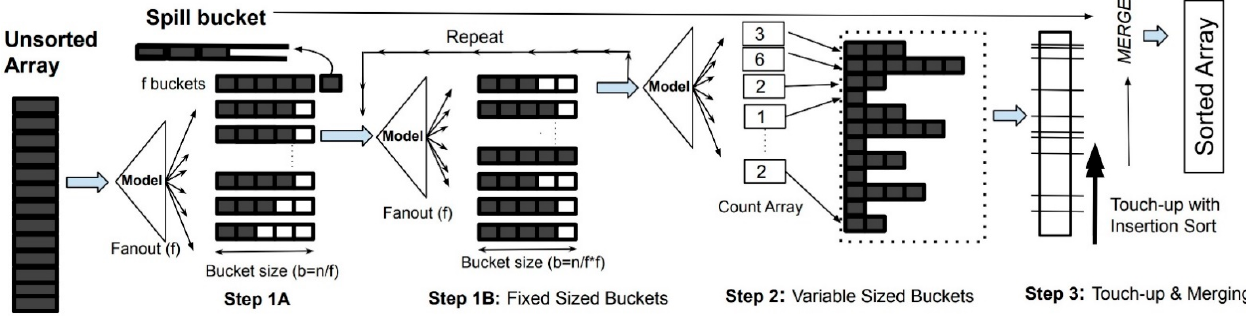
Figure 8. MER-sort (Model-Enhanced Radix Sort)